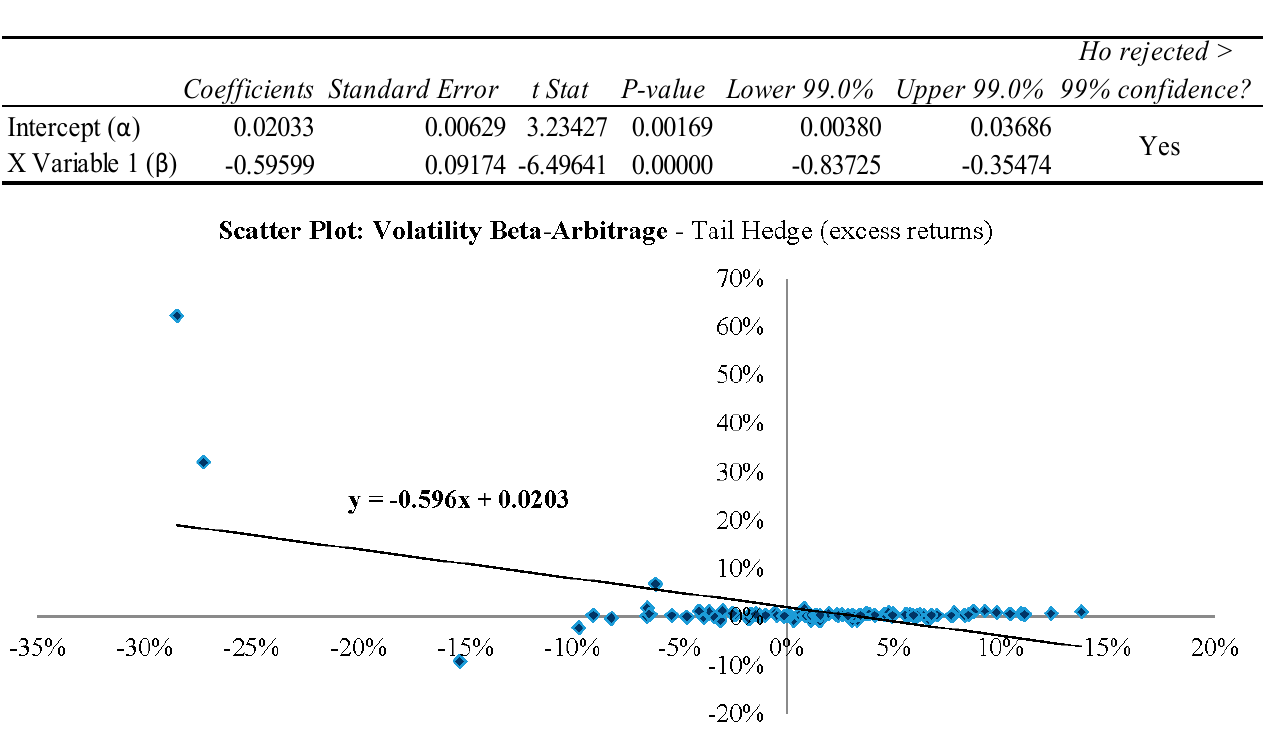
Figure A3. Note how, with this strategy, the counteraction to systematic risk is even more attractive in the sell off of 2008 .